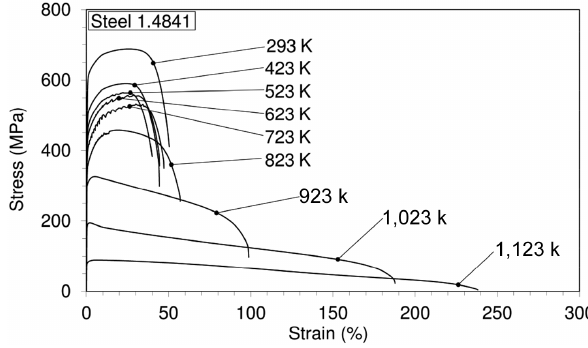
Figure 1: Engineering stress – strain diagrams for steel 1.4841 at